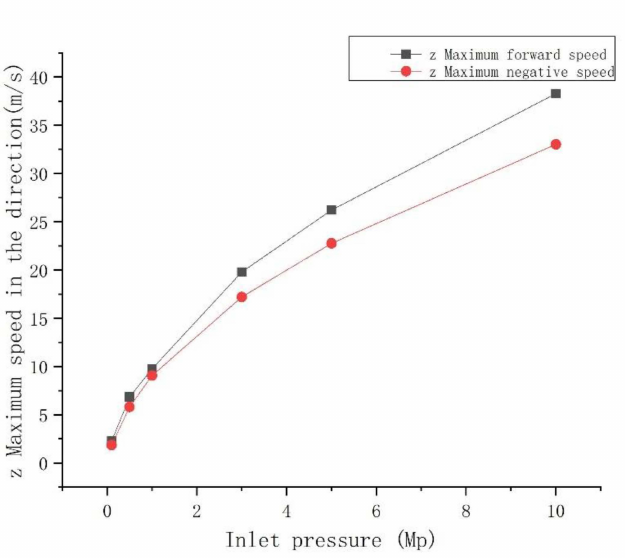
Figure 7. Velocity change diagram under different inlet pressure